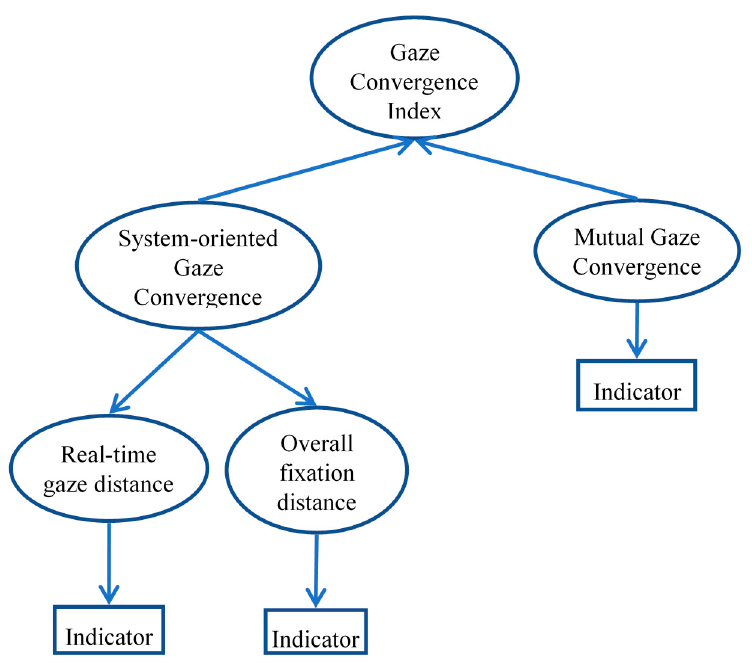
Figure 1. Gaze convergence index construct. Note. The oval forms represent constructs and the rectangles represent direct measure of the associated subconstruct.